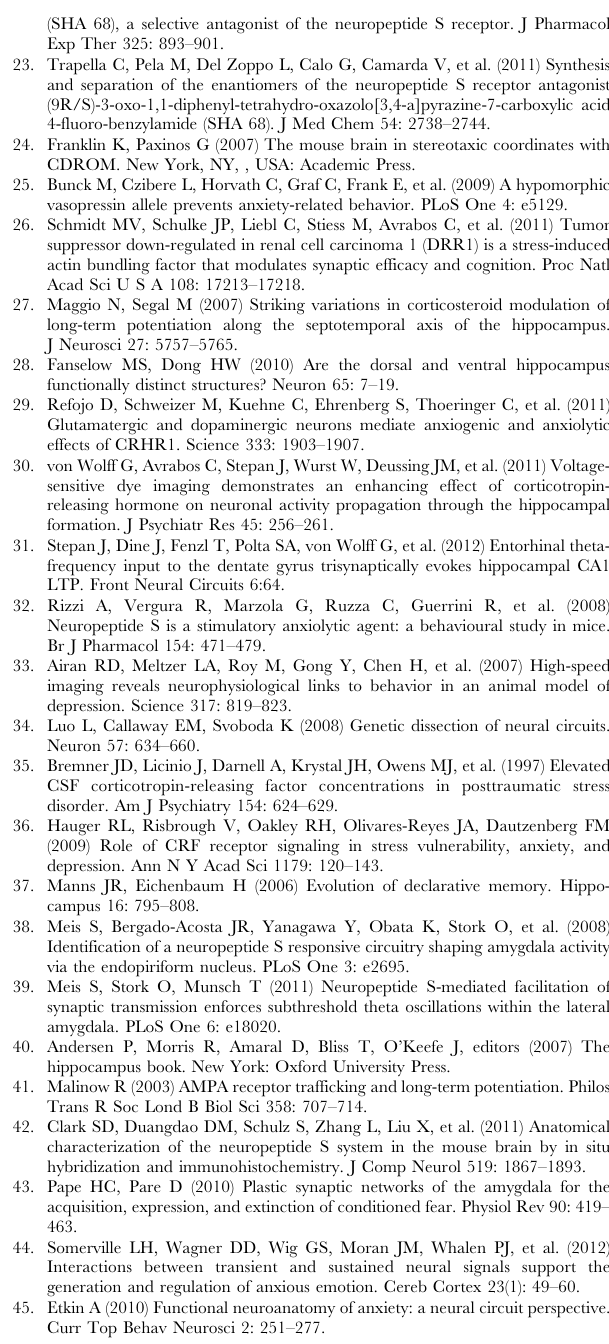
Figure S1 Procedure of the intranasal application of NPS. The awake mouse was restrained manually during the administration procedure in a supine position with the head immobile at an angle of approximatively 45 u to the body.